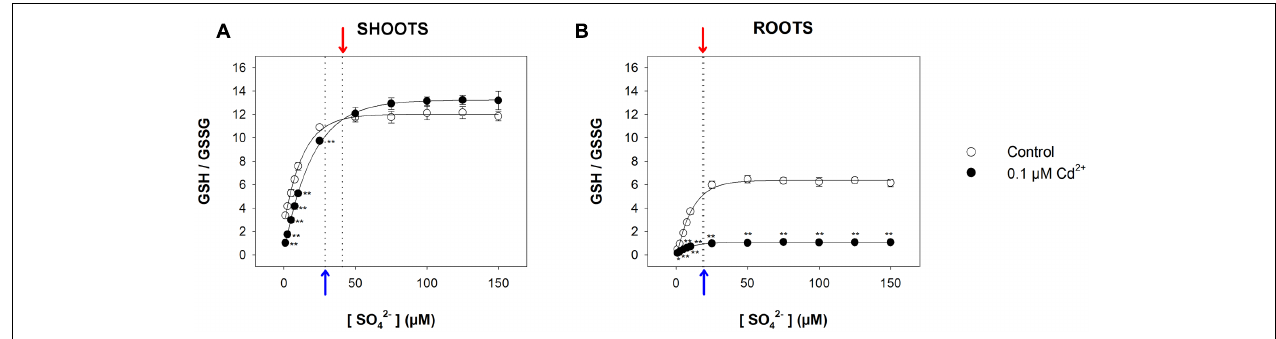
FIGURE 6 | Effect of long-term exposure to Cd on the GSH/GSSG ratio in shoots (A) and roots (B) . Arabidopsis plants were grown for 22 days under a wide range of sulfate concentrations (1, 2.5, 5, 7.5, 10, 25, 50, 75, 100, 125, and 150 µ M) in the presence or absence of 0.1 µ M Cd 2 + . The GSH/GSSG ratios were calculated using data about reduced GSH and GSSG reported in Supplementary Figure S3. Data are means and SE of two experiments run in triplicate ( n = 6). Asterisks indicate significant differences (Student’s t -test; ∗ 0.001 ≤ P < 0.05; ∗∗ P < 0.001) between control and Cd-exposed plants grown under the same sulfate external concentration. Blue and red arrows indicate the values of [SO 42 − ] crit calculated for control and Cd-exposed plants, respectively.